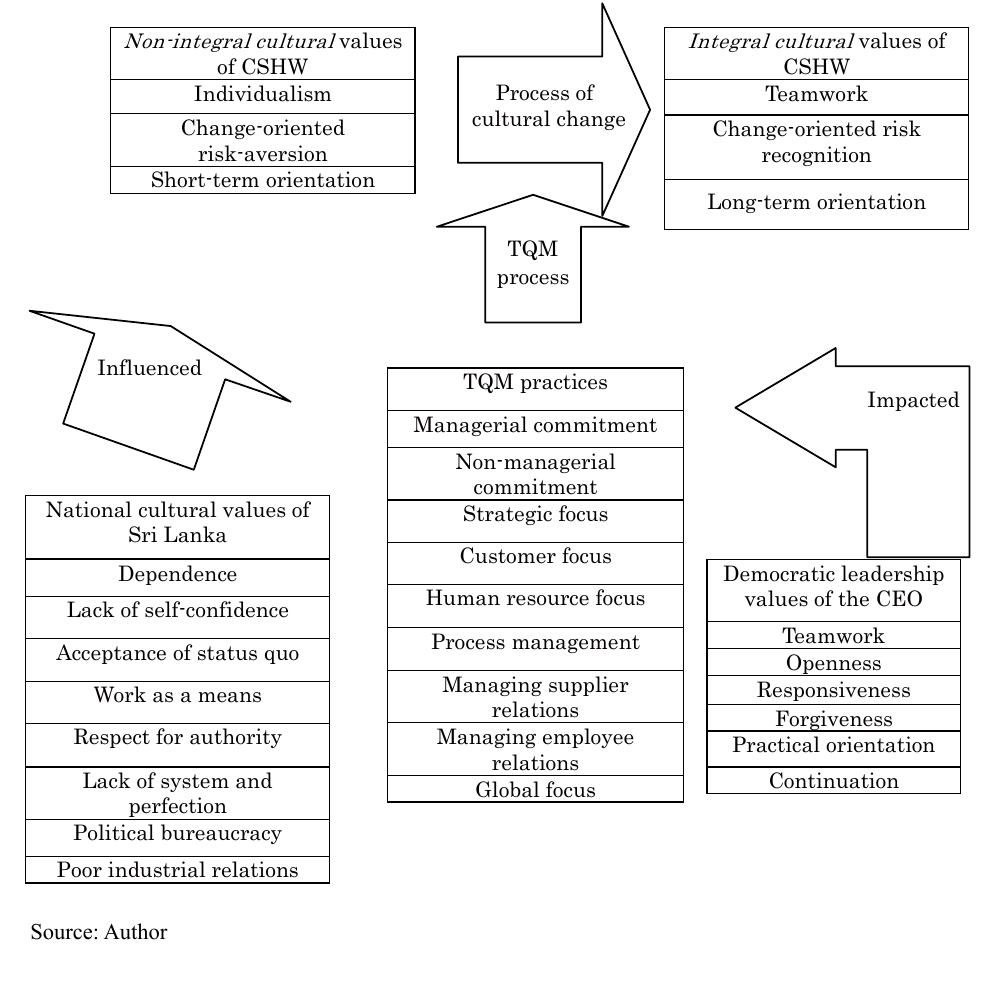
Figure 2. Cultural change at CSHW within the national cultural values of Sri Lanka